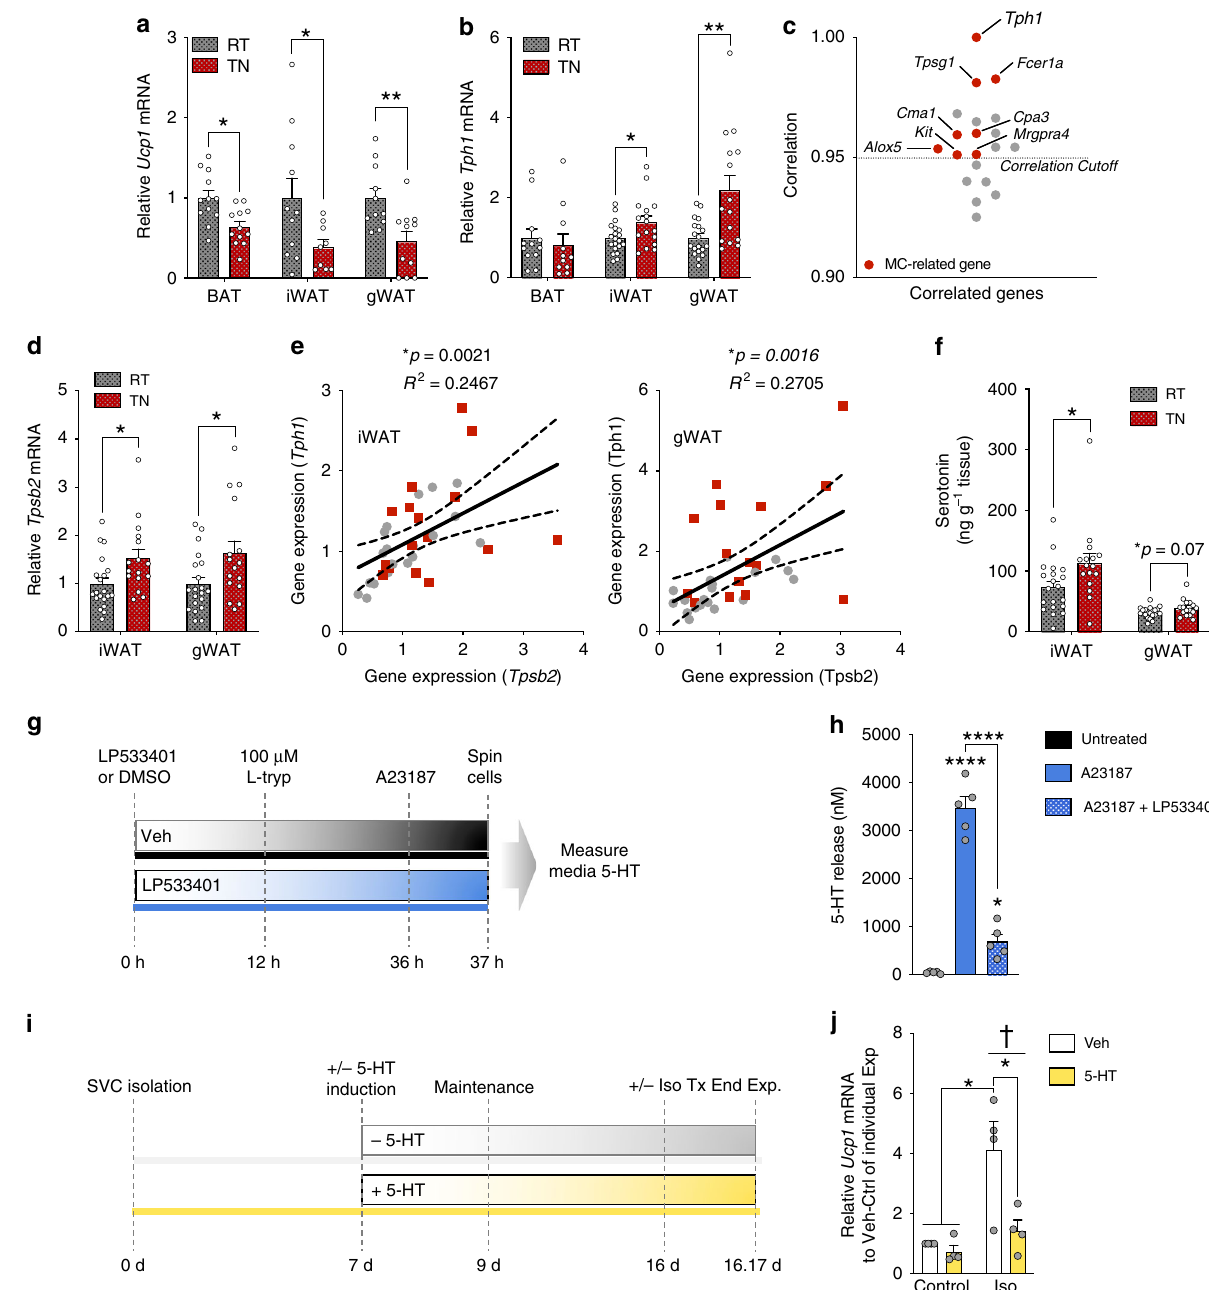
Fig. 1 Thermoneutrality reduces white adipose tissue Ucp1 and increases Tph1 , mast cells and serotonin in HFD-fed mice. a Ucp1 expression in BAT ( n = 12), iWAT ( n = 11 RT, 9 TN) and gWAT ( n = 11). b Tph1 expression in BAT ( n = 12 RT, 11 TN), iWAT ( n = 20 RT, 16 TN) and gWAT ( n = 19 RT, 15 TN). c BIOGPS Tph1 Correlations highlighting mast cell-related genes with greater than 0.95 cutoff. d Tpsb2 expression in WAT ( n = 20 RT, 16 TN). e Correlation between Tpsb2 and Tph1 expression of RT (grey dots) and TN (red squares) housed mice in iWAT (n = 36) and gWAT ( n = 34) Slopes